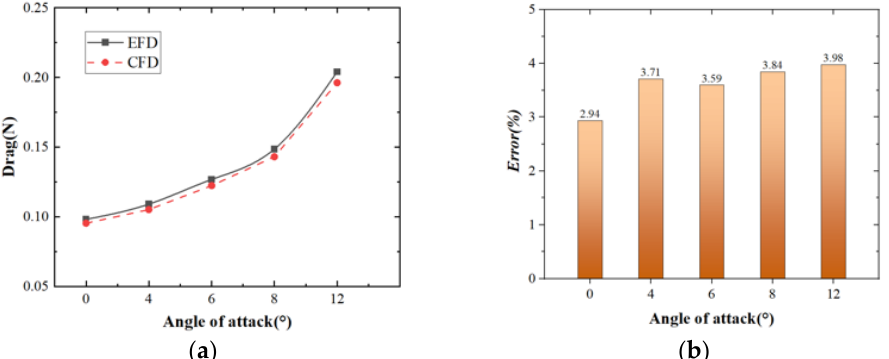
Figure 17. Numerical towing tank with the boundary conditions.